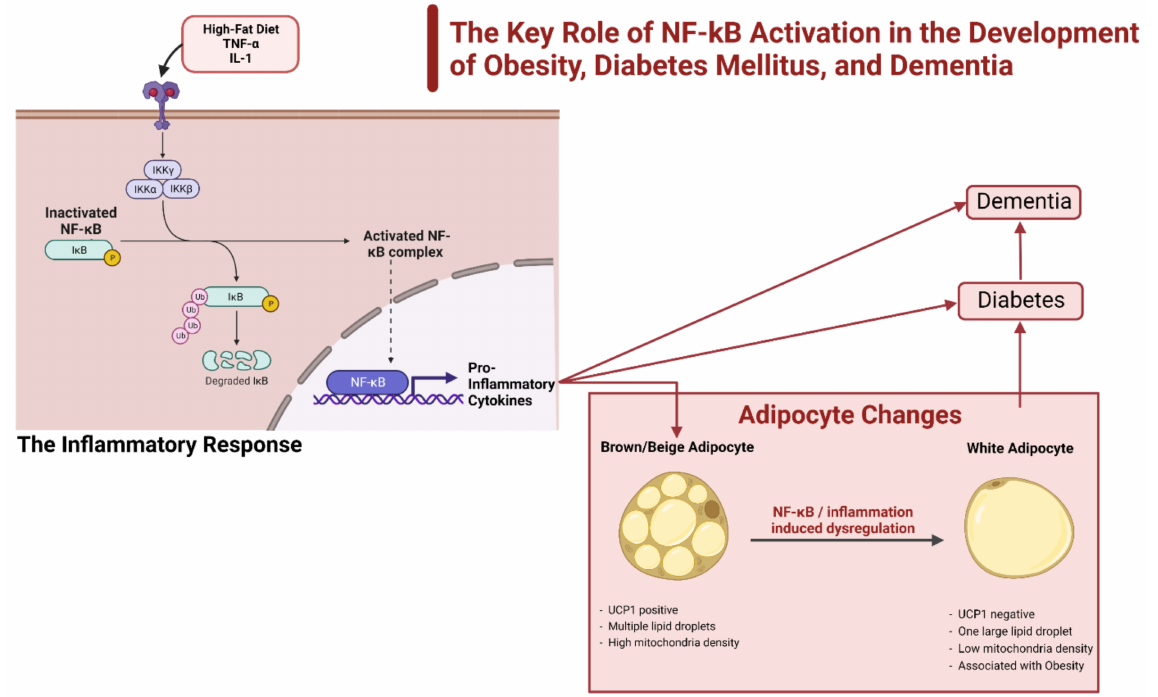
Figure 5. Role of NF- κ B activation in the development of obesity, diabetes mellitus, and dementia. Activation of NF- κ B is a nuclear transcription factor linked to the ignition of inflammation via the release of inflammatory cytokines (e.g., IL-1, IL-1 β ) that leads to the dysregulation of several pathways throughout the body. One noteworthy impact of this inflammation is the transformation of brown adipose tissue (BAT) to white adipose tissue (WAT). High WAT content is a hallmark of obesity, and from obesity, diabetes and dementia develop. Note that inflammation lends itself to the direct development of both diabetes and